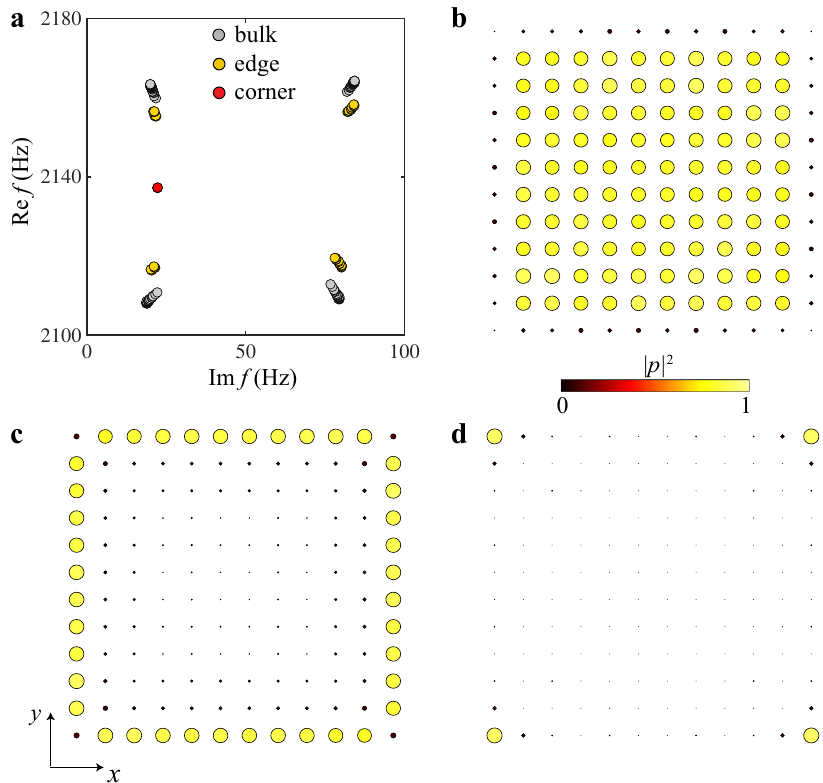
Fig. 2 Eigenstates for a fi nite nontrivial lattice. a Numerically calculated eigenfrequencies of the nontrivial lattice with 12 resonators along x and y directions. Gray, yellow, and red dots represent bulk, edge, and corner states, respectively. b – d Sum of probabilities for the bulk ( b ), edge ( c ), and corner states ( d ), respectively.